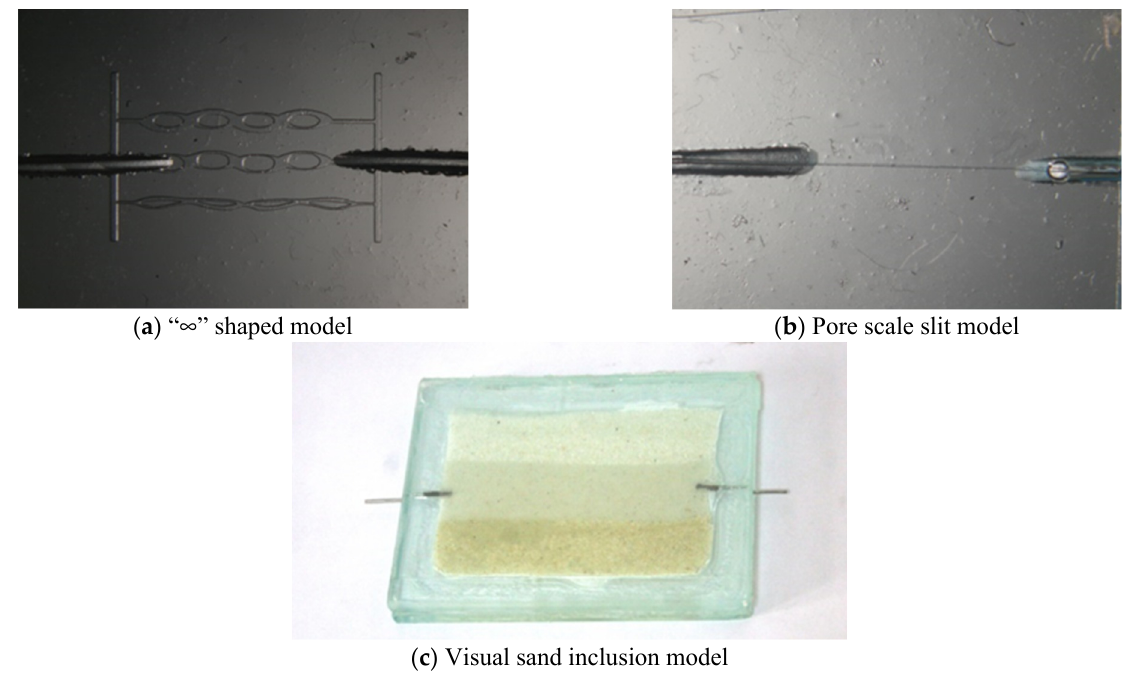
Figure 10. Three test models. ( a ) “ ∞ ” shaped model, ( b ) Pore scale slit model, ( c ) Visual sand inclusion model.